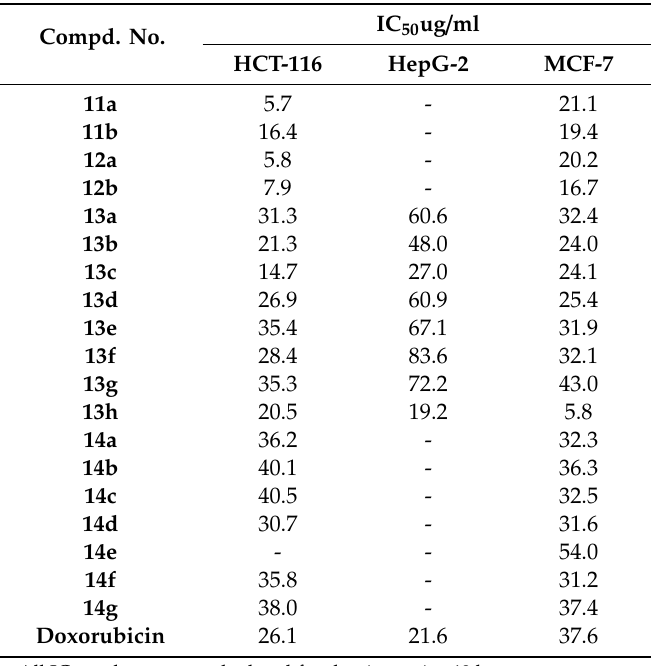
Table 4. IC 50 values of spiro pyrazole-oxindole congeners against human cancer cell lines. Compd.